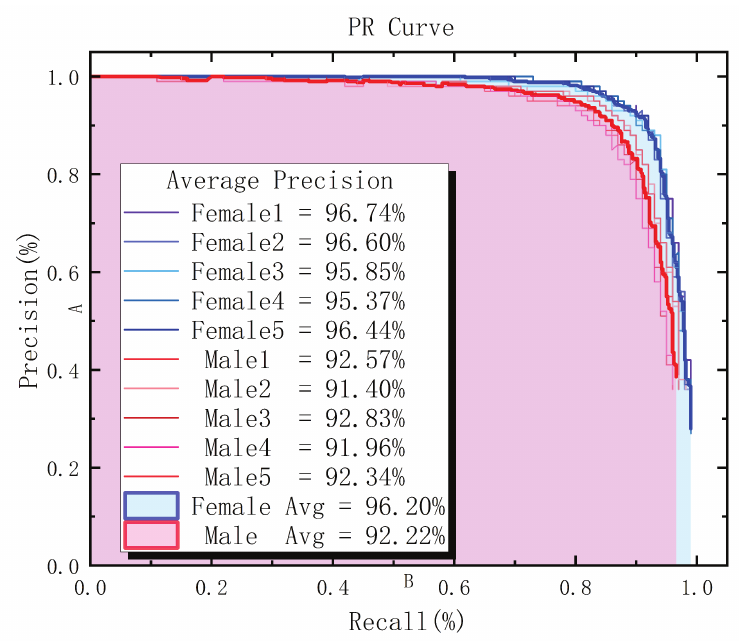
Figure 9. PR curves of litchi female and male flowers for the distilled model.